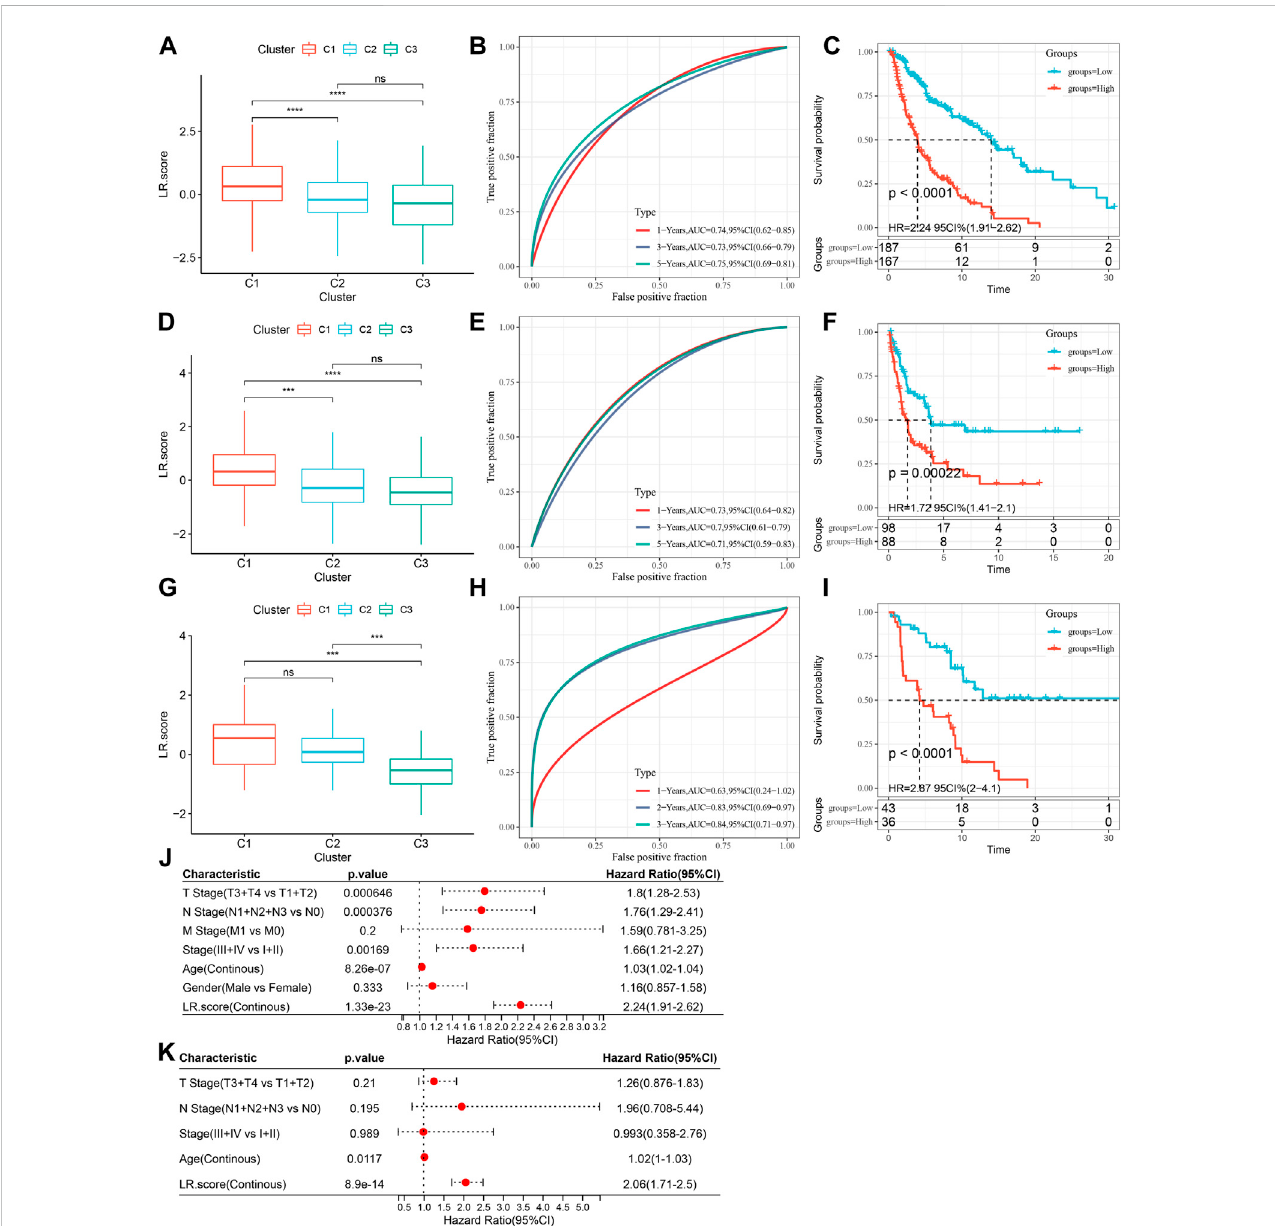
FIGURE 7 Scoring model based on ligand-receptor pairs (A) LR.score differences in multiple LR.score groups in the TCGA-SKCM cohort. (B) Survival analysis in the highandlowLR.scoregroupsintheTCGA-SKCM cohort. (C) ThepredictivevalueofLR.scoreinpatientsamongtheTCGA-SKCM cohort(AUC:0.74,0.73and 0.75; 1, 3 and 5-years overall survival). (D) LR.score differences in multiple LR.score groups in the GSE65094 cohort. (E) LR.score high and low groups in the GSE65094 cohort Survival analysis. (F) The predictive value of LR.score in patients among the GSE65094 cohort (AUC: 0.73, 0.70 and 0.71; 1, 3 and 5- yearsoverallsurvival). (G) LR.scoredifferencesinmultipleLR.scoregroupsintheGSE54467cohort. (H) SurvivalanalysisinhighandlowLR.scoregroupsofthe GSE54467 cohort. (I) The predictivevalueofLR.scoreinpatientsamongtheGSE54467cohort(AUC: 0.63,0.83 and0.84; 1,3and5- yearsoverallsurvival). (J) Univariate Cox regression model analysis, which included the factors of LR.score, patient age, gender, TNM stage and patient outcomes in the TCGA-SKCM. (K) Multivariate Cox regression model analysis, which included the factors of LR.score, patient age, gender, TNM stage and patient outcomes in the TCGA-